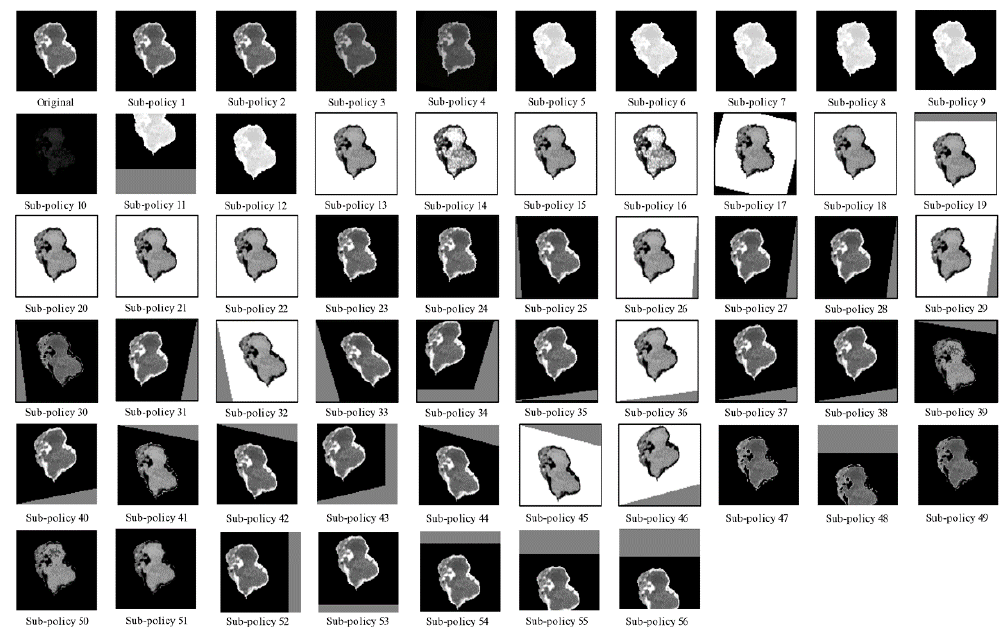
Figure 4. Augmented data with 56 subpolicies (taking a grade 4 glioma as an example).